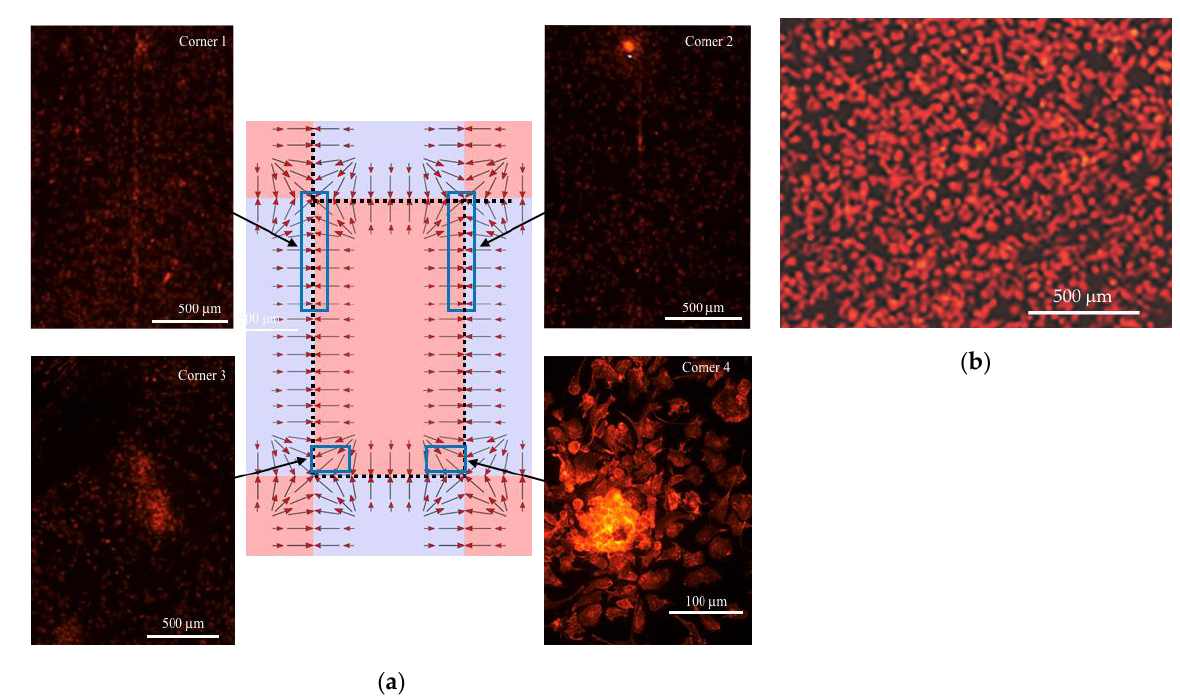
Figure 5. Pattern of the macrophages’ density in the magnetic field with no contrast agent added. ( a ) Macrophages were grouped above the central magnet corners and along the edges according to the magnetic gradient field and generated mechanical force patterns. The magnitude of the field gradients was the largest along the central magnet edges. The arrows show the direction of the mechanical force acting on the macrophages. ( b ) evenly distributed macrophages grown without magnetic field applied (stained red with Rhodamine phalloidin for actin) are shown as a control image.